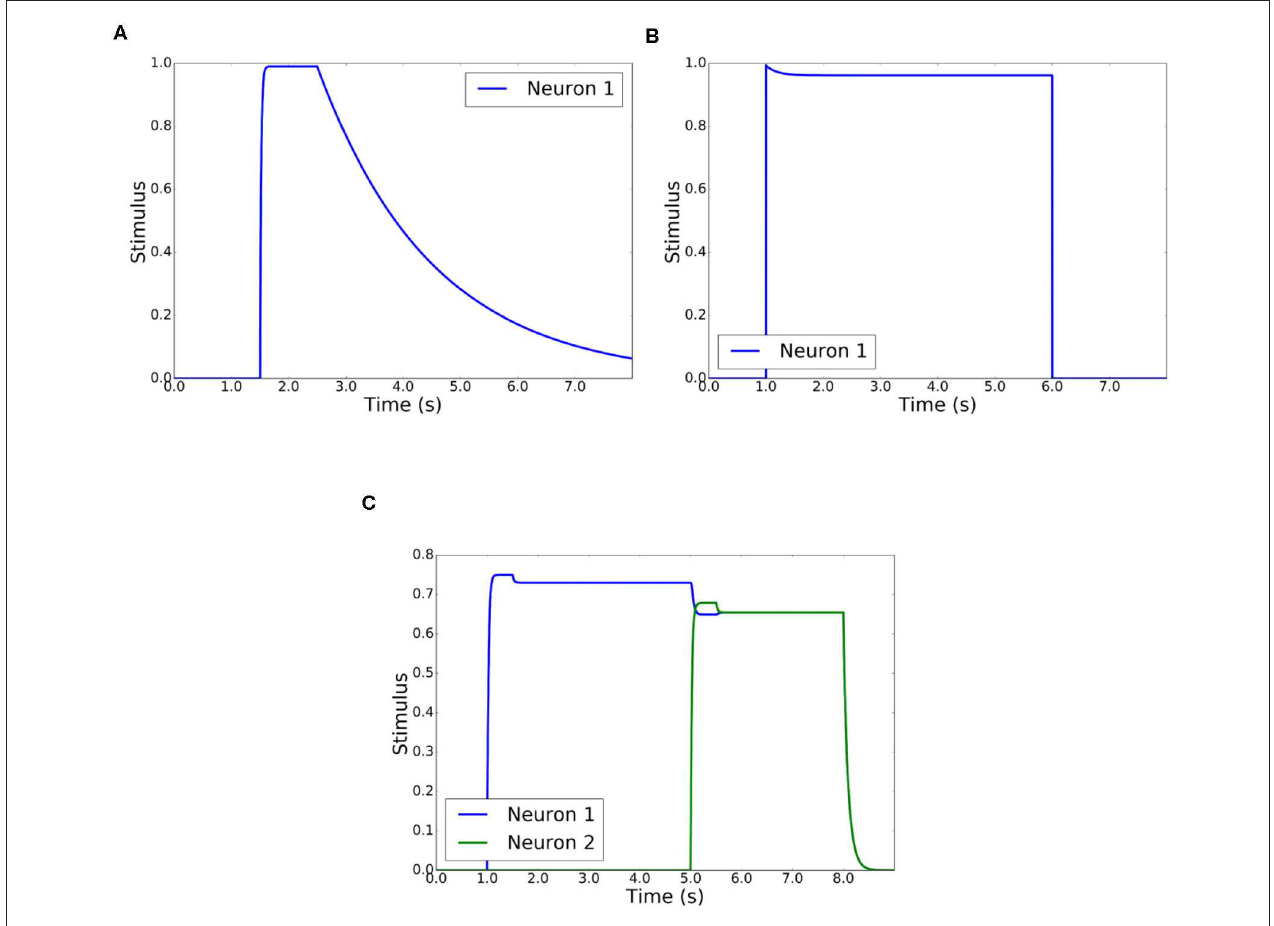
FIGURE 6 | STM, habituation, and competitive layer behavior. (A) STM layer behavior when there is a short duration stimulus. A 1 = 0.2, B 1 = 1, and C 1 = 0.5. (B) Habituation layer behavior when there is a long duration stimulus. E = 0.5, F = 0.02. (C) Behavior of competitive layer with 2 neurons. A 2 = 1, B 2 = 1, and C 2 = 3, D = 1, E = 0.5, and F =